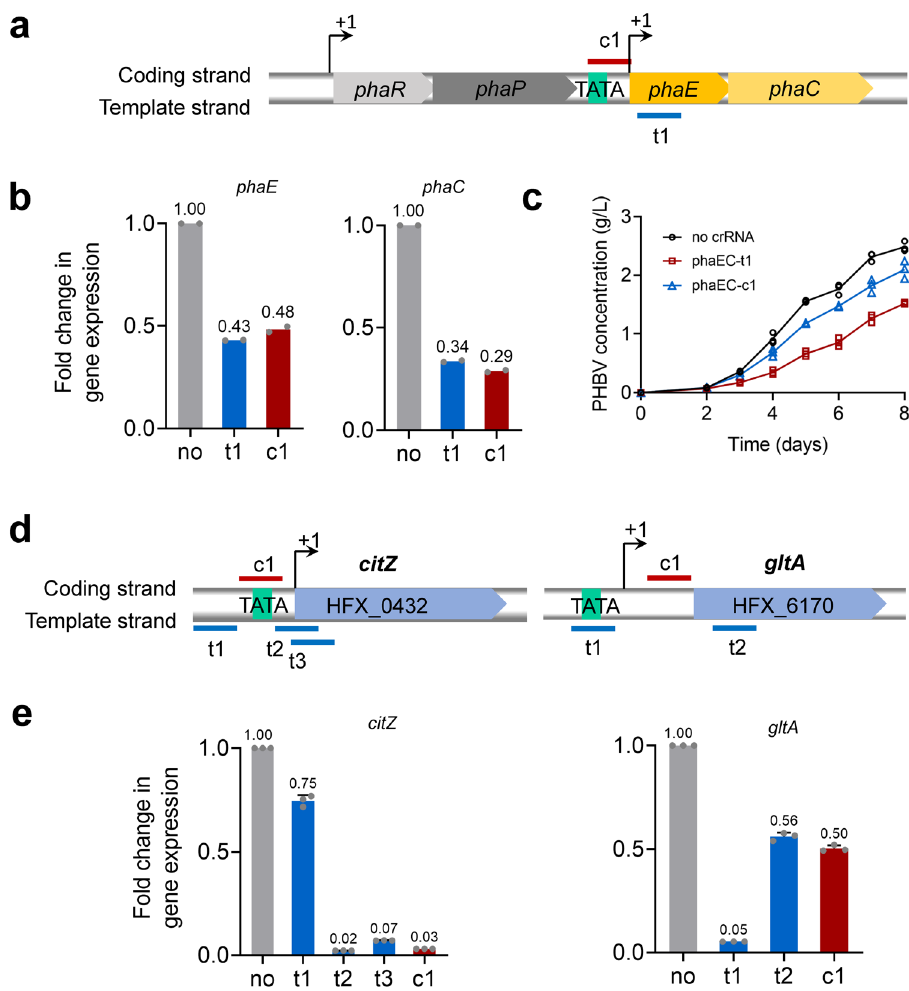
Fig. 4 Repression of phaEC and citrate synthase genes using CRISPRi. a Location of crRNA target sites in phaEC . phaEC are transcribed driven by two promoters of P phaR and a weaker promoter upstream of phaEC . t1 and c1 are designed to target the template strand and coding strand of phaEC , respectively. b RT-qPCR analysis of phaE and phaC expression levels. c PHBV production. d Location of crRNA target sites in citZ and gltA . citZ is transcribed from the A of the start codon ATG. t1, t2 and t3, and c1 are crRNAs targeting the template strand and coding strand of citZ , respectively. The TSS of gltA is 155 bases from the start codon. t1 and t2, and c1 are crRNAs targeting the template strand and coding strand of gltA , respectively. e Fold change in the expression of citZ and gltA . Data shown for two ( b ) or three ( c , e ) biological replicates. Error bars indicate SDs, n =